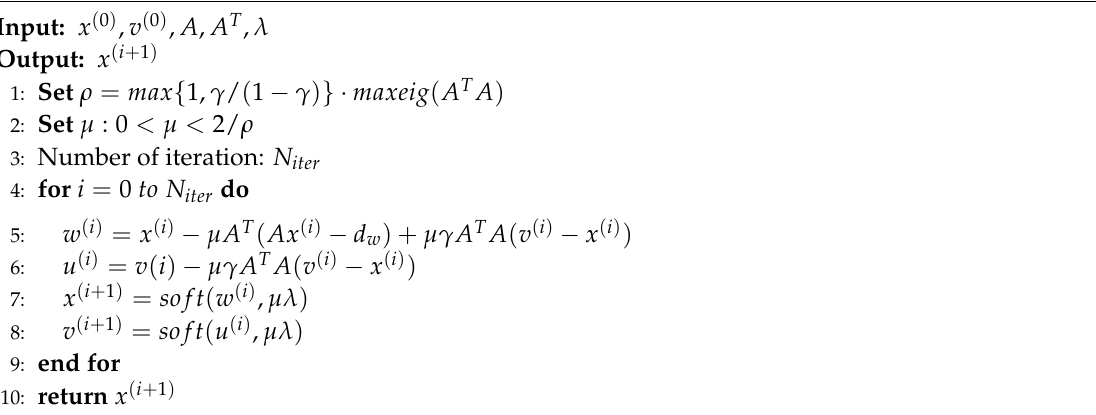
Algorithm 2 FBS algorithm for GMC penalized least squares problem